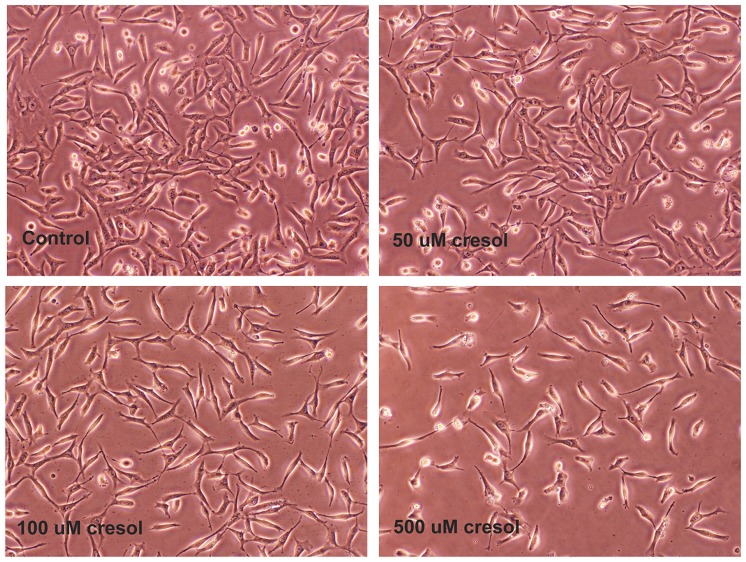
Morphology of EAHY endothelial cells (1×104 cells/well) after exposure to p-cresol for 3 days.Density of EAHY cells markedly decreased. One representative picture of EAHY cells was shown.